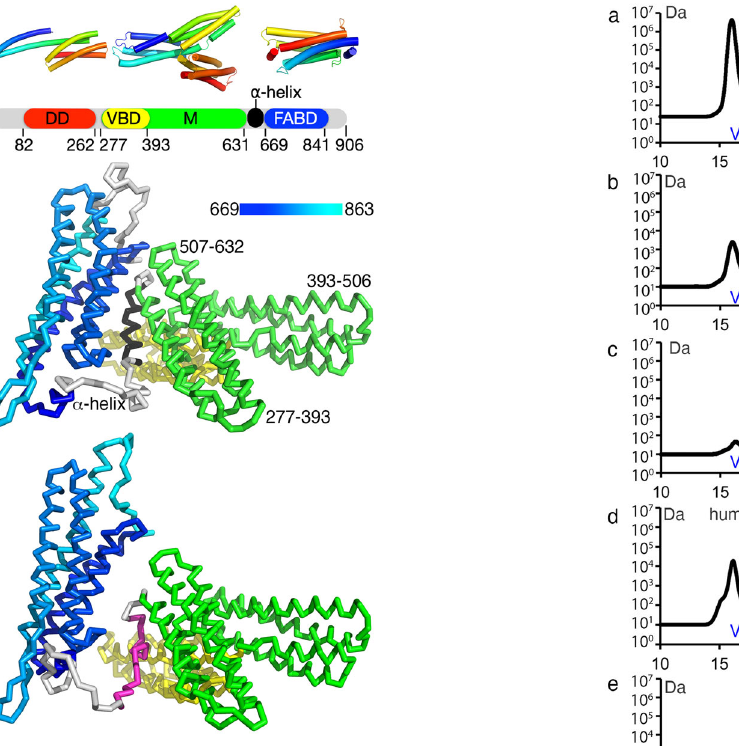
Fig. 1 The monomeric α -catenin cryoEM structure reveals interdomain interactions with the F-actin binding domain (FABD) and an ordered α -helix. a Domain structure of α -catenin. Top structures of the individual domains are colored spectrally from shorter to longer wavelengths. Bottom, domain boundaries are shown and indicated by their residue numbers (DD, dimerization domain; VBD, vinculin binding domain; M, middle domain; FABD, F-actin binding domain). The VBD is part of the middle domain. The FABD is a 5-helix bundle plus two short α -helices on either end. b Cartoon of our monomeric α -catenin cryoEM structure. The VBD is shown in yellow, the remainder of the middle domain is in green, and the carboxy-terminal FABD is colored blue to cyan for residues 669 to 863. The linker residues (636-650, black) that form an unexpected α -helix are indicated. c The starting AlphaFold model does not have the extra α -helix (magenta) and the FABD (colored from blue to cyan) is further away from the middle domain (green) compared to our fi nal re fi ned model.